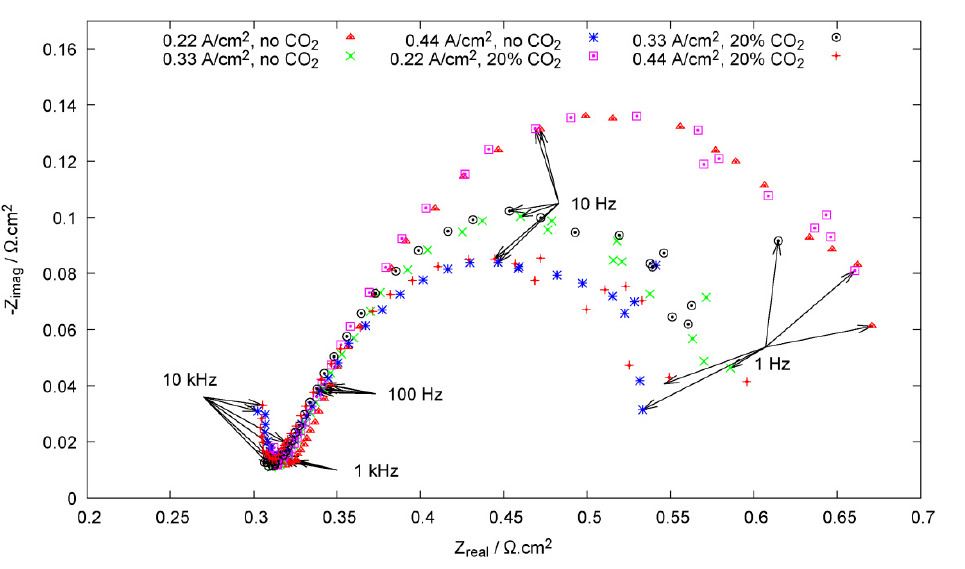
Figure 6. The effect of current density on a PBI-based HT-PEMFC operating at 160 °C both in the absence and in the presence of CO